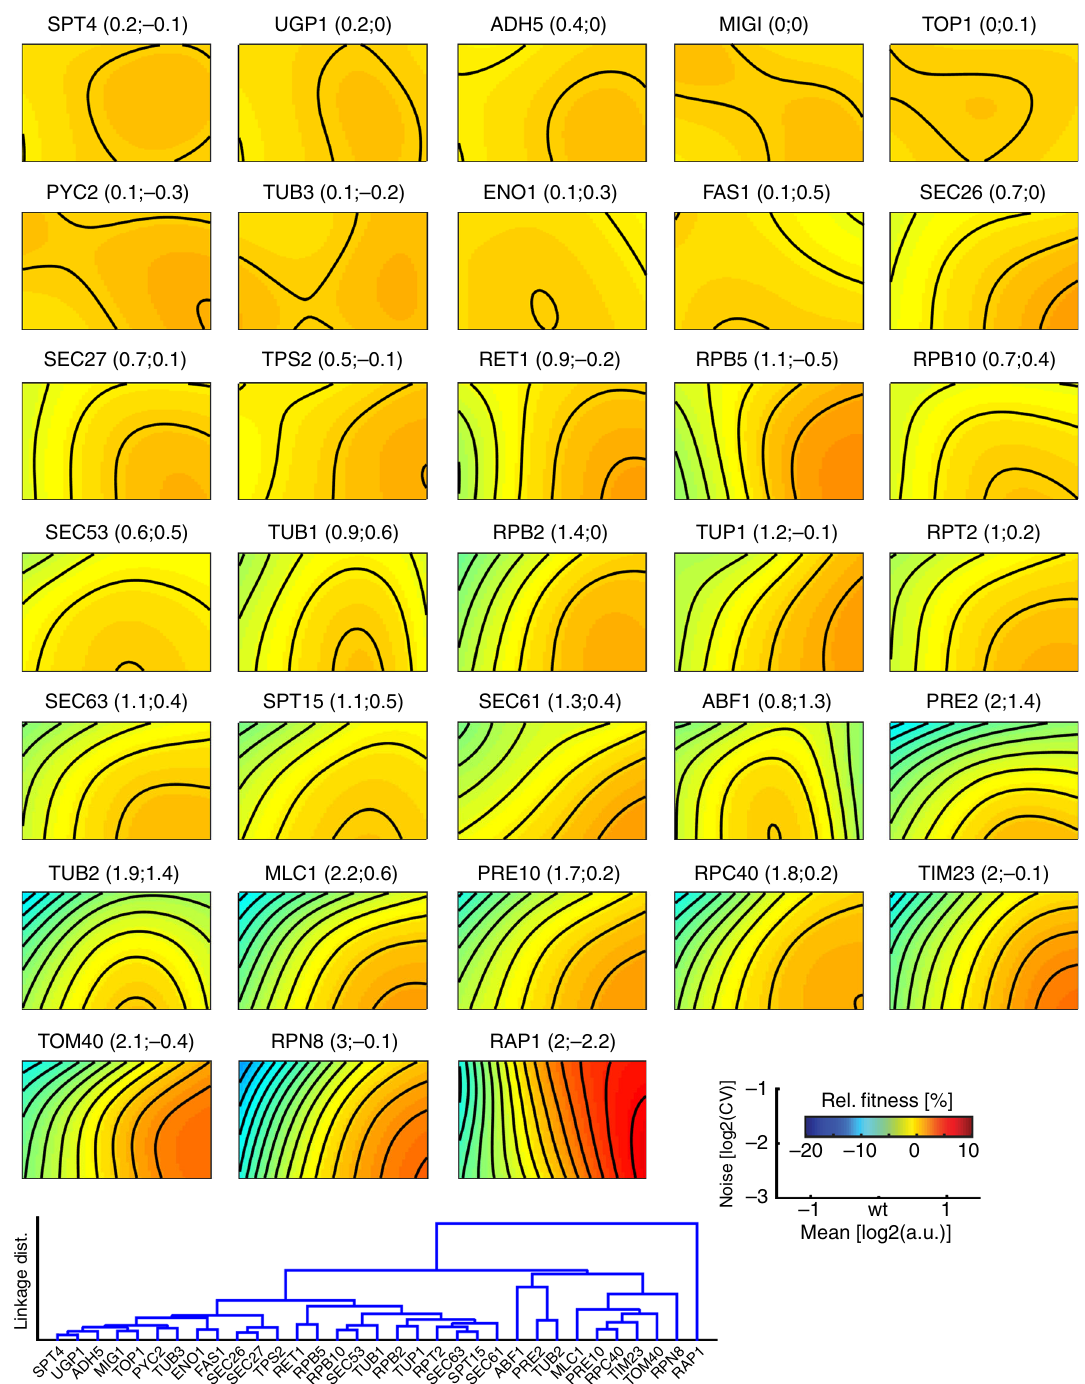
Fig. 3 Expression- fi tness landscapes in mean-noise space around wild-type mean expression. Expression- fi tness landscapes for the investigated 33 yeast genes. Landscapes are ordered according to hierarchical clustering of Euclidean distances between fi tness pro fi les (see linkage graph in lower left). Mean expression is limited to ±1.5 log 2 -units around genes ’ wild-type mean expression. Colours indicate fi tness relative to wild-type mean expression and lowest noise level; contours are spaced in increments of 0.01 fi tness units. Plot titles give gene name and principal topology 1 and 2 loadings, respectively (related to Fig.